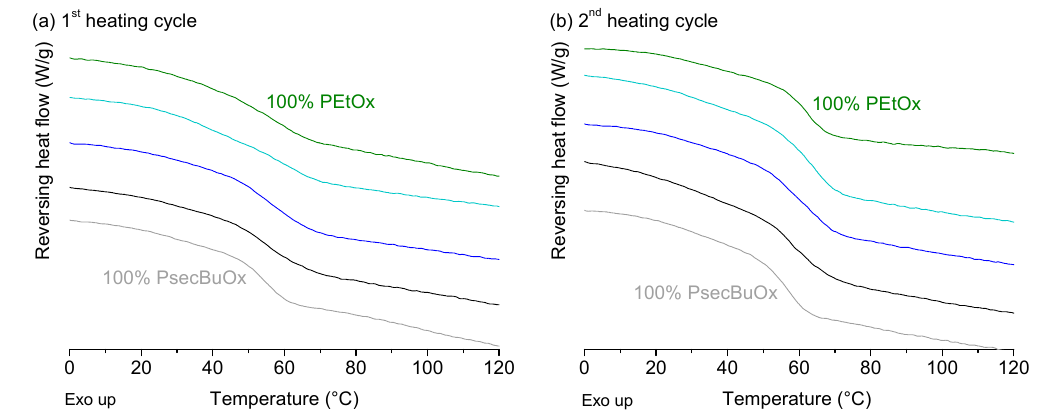
Figure 7. First ( a ) and second ( b ) heating cycle of film-casted PEtOx (green), PEtOx / PsecBuOx 2 / 1 ( m / m ; cyan), PEtOx / PsecBuOx 1 / 1 ( m / m ; blue), PEtOx / PsecBuOx 1 / 2 ( m / m ; black) and PsecBuOx (grey). The T g s of pure PEtOx and PsecBuOx are in each other’s vicinity and thus make it difficult to